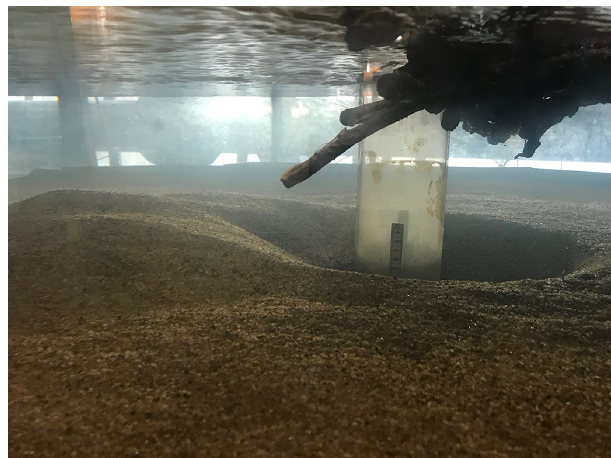
Figure 1. Debris accumulation formed in the laboratory and devel- oped scour hole (Cantero-Chinchilla et al.,